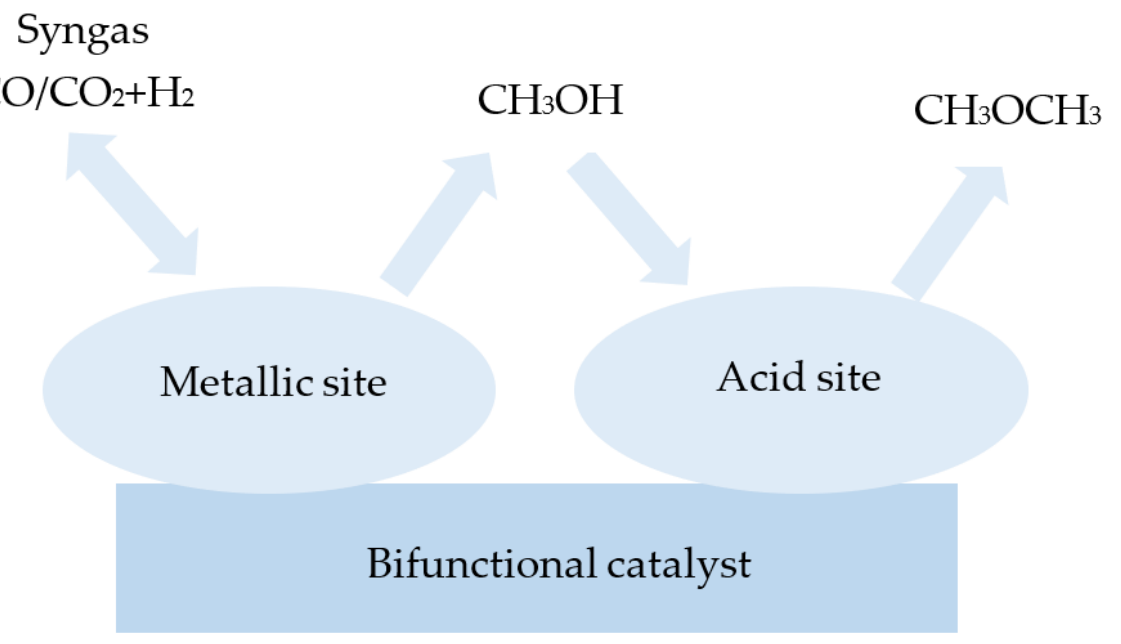
Figure 4. Scheme presenting the general structure of a bifunctional catalyst.